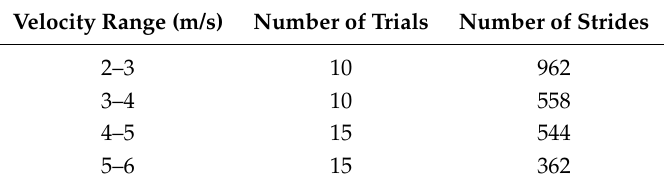
Table 2. Number of trials and recorded strides per velocity range. During the data acquisition, we controlled for speed and the subjects only changed the velocity range, if the required number of trials in the previous (slower) velocity range was reached.